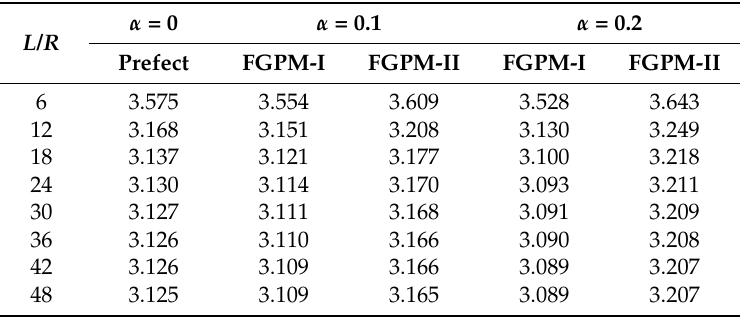
Table 12. Variation of natural frequency ω (GHz) against length-to-radius ratio L / R of different types of porous FGPM cylindrical nanoshell ( n = 3, N = 20). α = 0 α = 0.1 α = L/R